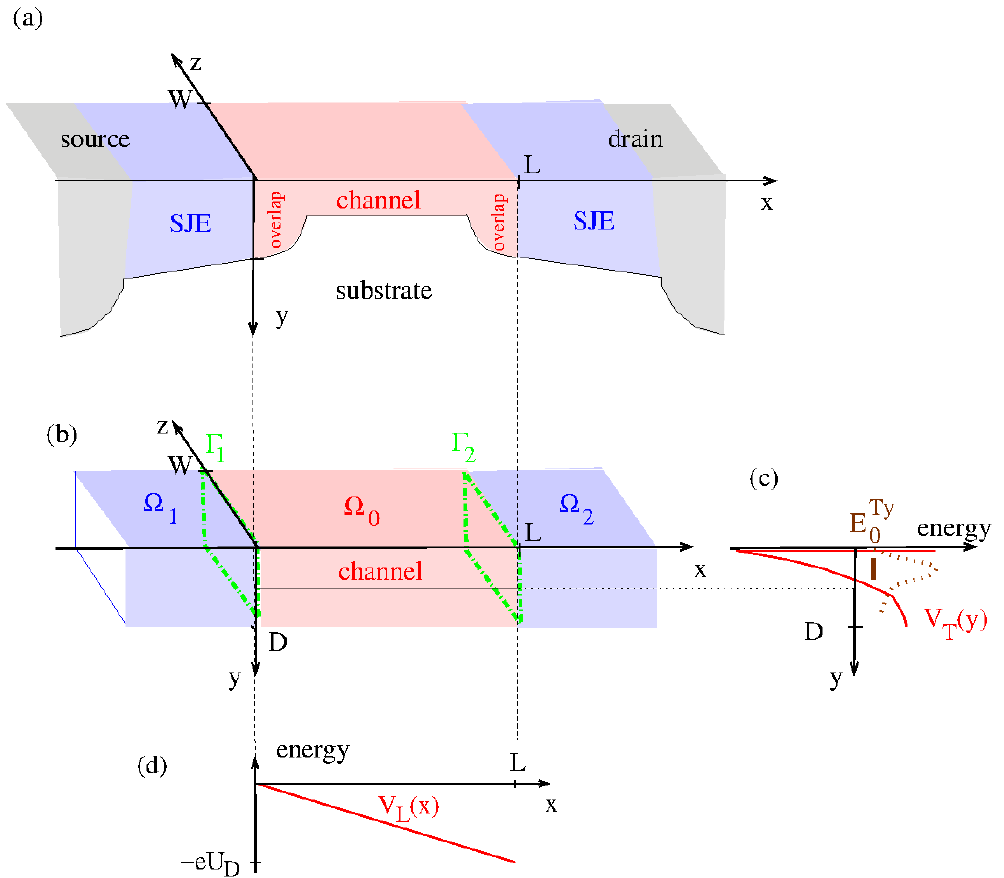
Figure 2. ( a ) Structure elements of a conventional nano-MOSFET: Source- and drain contact with shallow junction extensions SJEs, the latter in blue. In red the conduction channel and the overlap between conduction channel and SJE. The semiconductor-insulator interface is located at y = 0. ( b ) Assignment of the above structure elements to the structure elements of the general multi-terminal system in Figure 1: The SJEs are associated with cubic contact regions Ω s . ( c ) In red: Transverse confinement potential V T ( y ) of the conduction channel in the separable ansatz for the potential in Equation (35). In brown the lowest subband energy E Ty in the channel confinement potential as defined 0 in Equation (62) (solid) and the corresponding eigenfunction (dotted). ( d ) Linear drop of the applied drain voltage leading to a linear longitudinal potential V L ( x ) in Equation